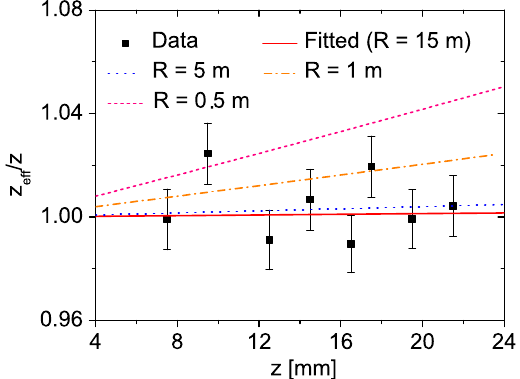
FIG. 14. The periodicity of the Talbot oscillations is affected by a non-vanishing curvature of the coherence areas. Since for visible wavelength the coherence areas at the sample position behave as far field speckles, they carry the same curvature as the SR wavefront. Data are compatible with a radius of curvature larger than 5 m.